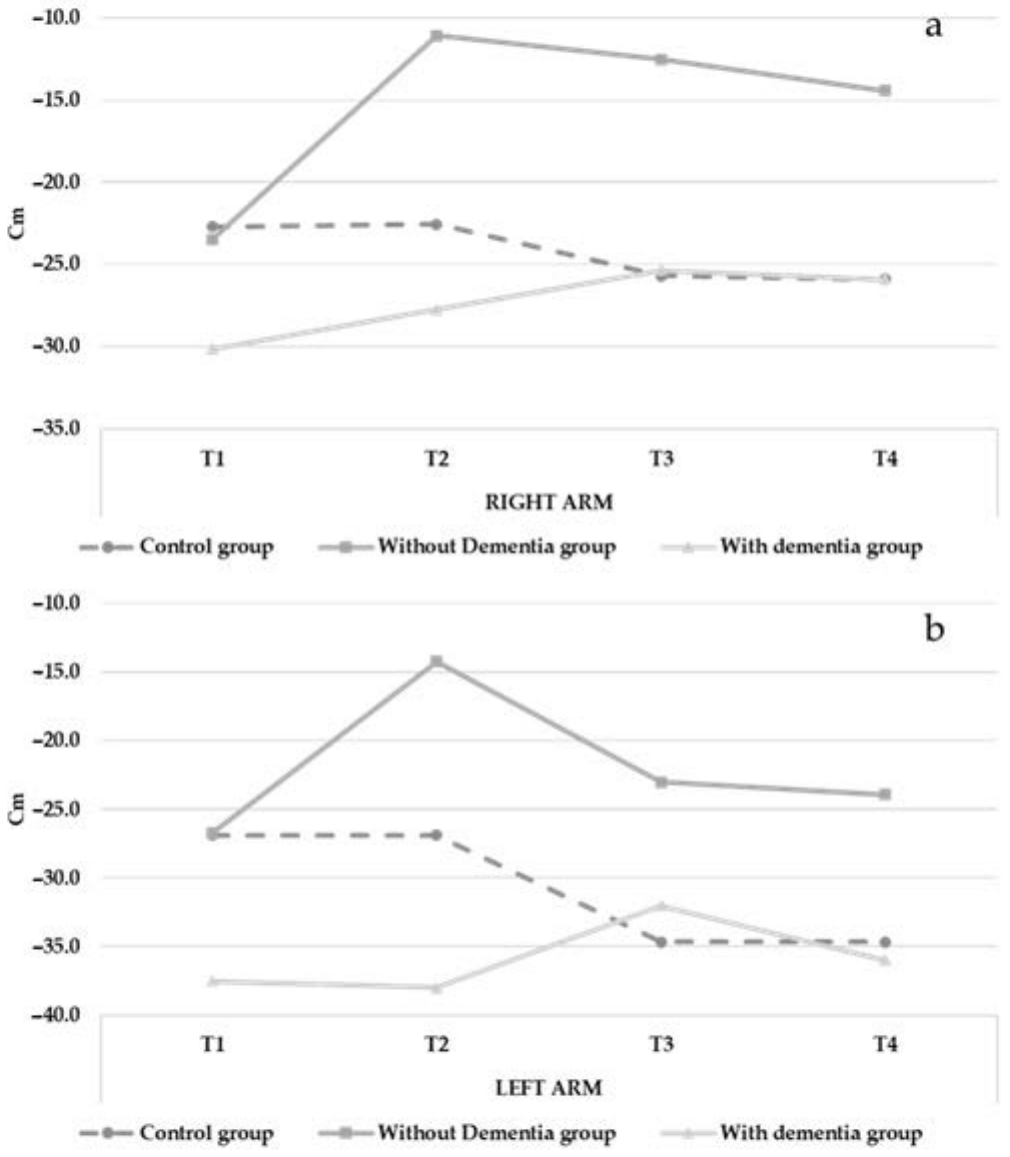
Figure 4. Changes in flexibility (Back Scratch test) over time (right arm = a ; left arm = b